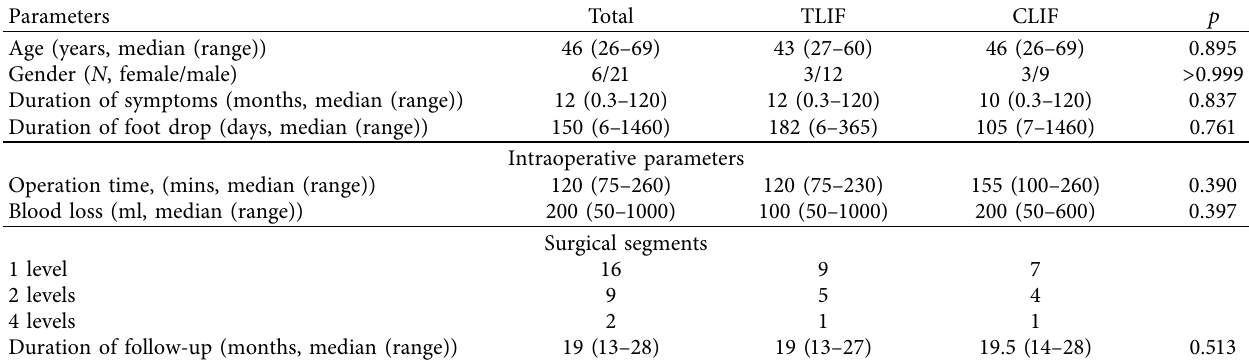
Table 1: Clinical characteristics of patients in the TLIF group and CLIF group.